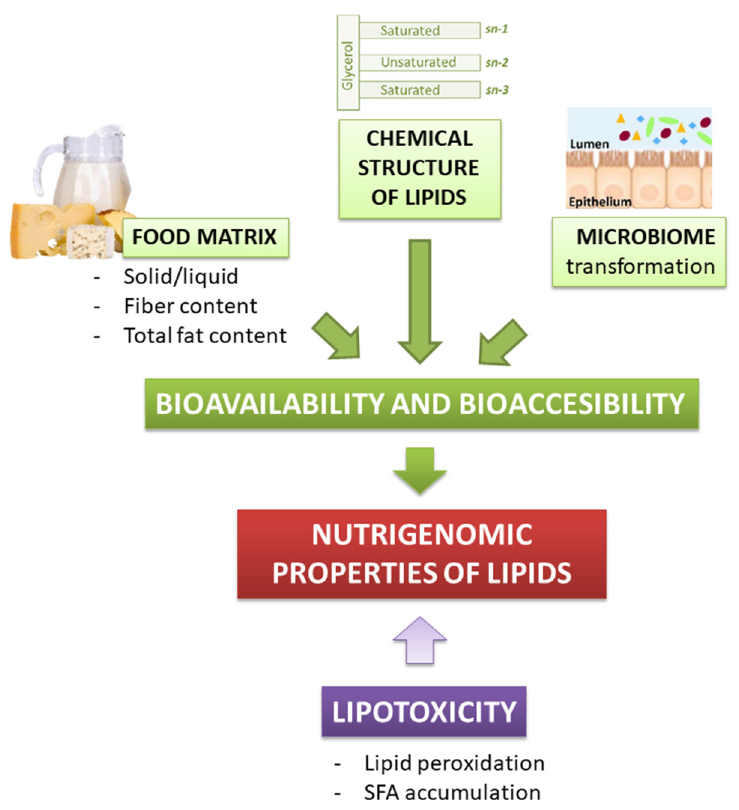
Figure 2. Dietary lipids bioavailability, bioaccessibility, and lipotoxicity contribute to their nutrigenomic properties .